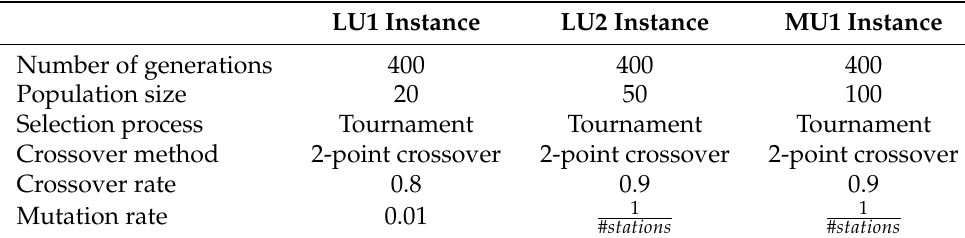
Table 5. NSGA-II configuration